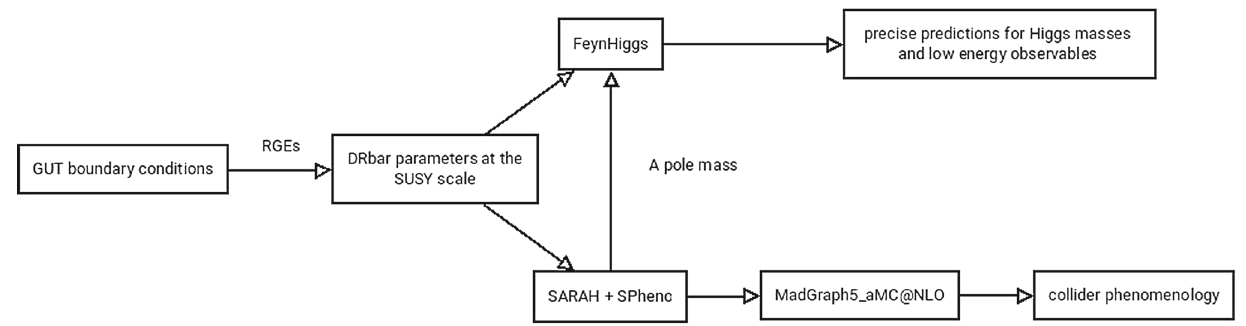
Fig. 1 Flow of information between used computer codes (see text for